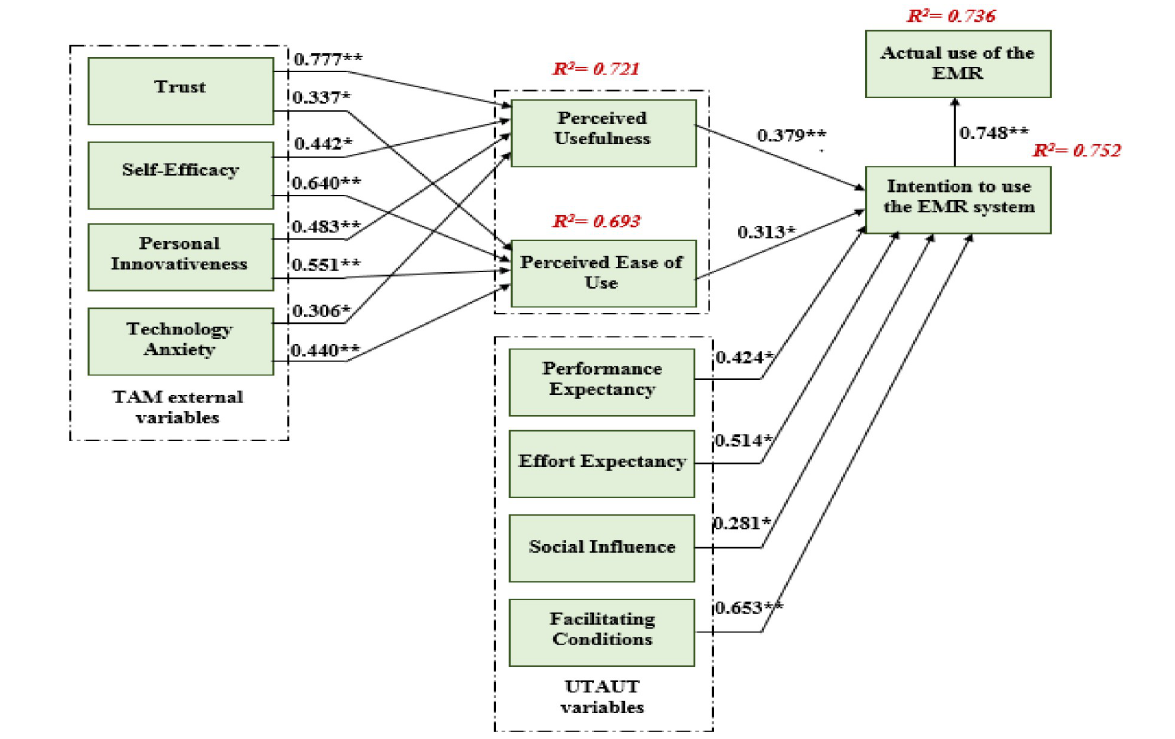
Fig 2. Path coefficient of the model (significant at p �� < = 0.01, p � < 0.05).